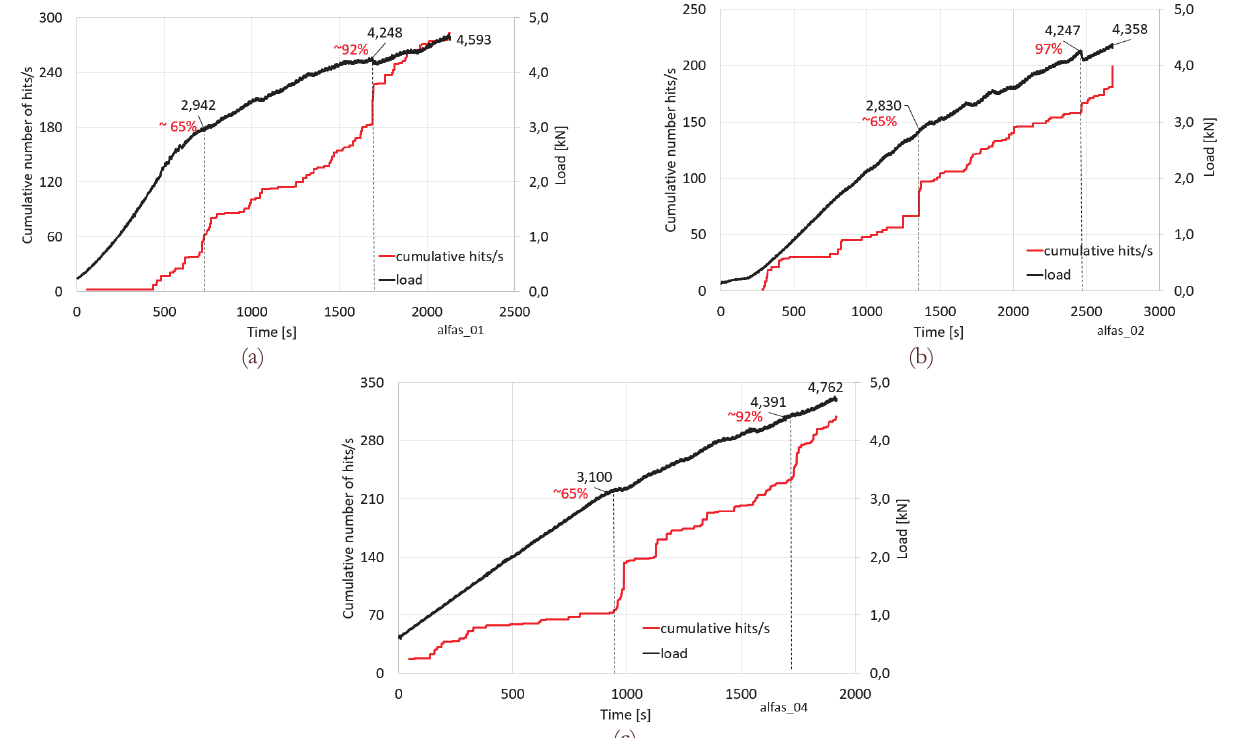
Figure 8: (a)-(c) The time variation of the cumulative hits/s for three characteristic 3-point bending experiments with specimens made of Alfas stone